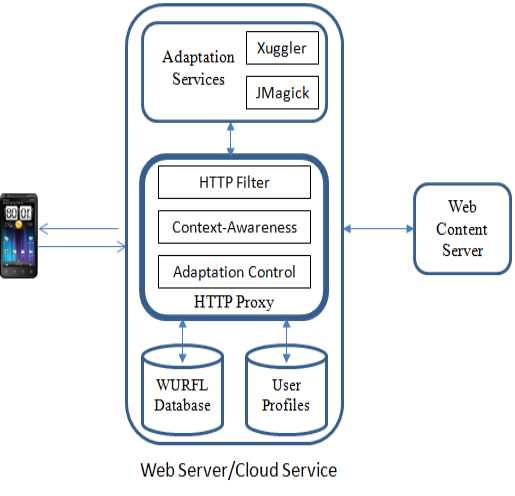
Fig. 1. The Overall Architecture of CADAMA CADAMA is independent of mobile